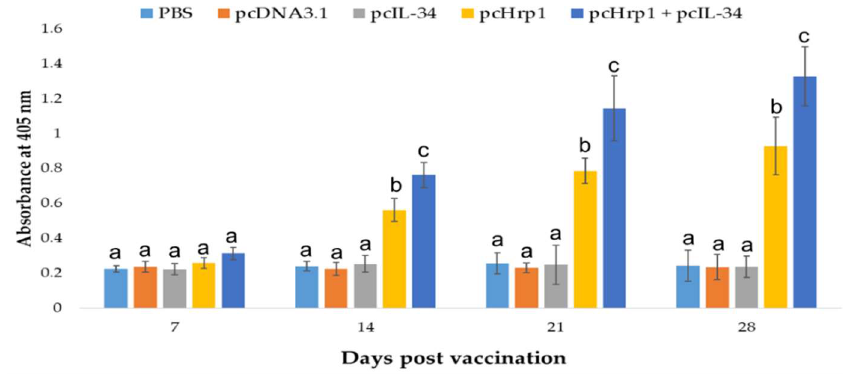
Figure 9. The detection of specific antibody production in immunized fish using ELISA. Largemouth bass were immunized with PBS, pcDNA3.1, pcIL-34, pcHrp1 and pcHrp1+pcIL-34, respectively. Sera were collected from 7 days to 28 days post-vaccination. Data are presented as means ± SD (n = 5). a,b,c,d A significant difference ( p < 0.05) exists between groups at the same time point with different superscript letters.